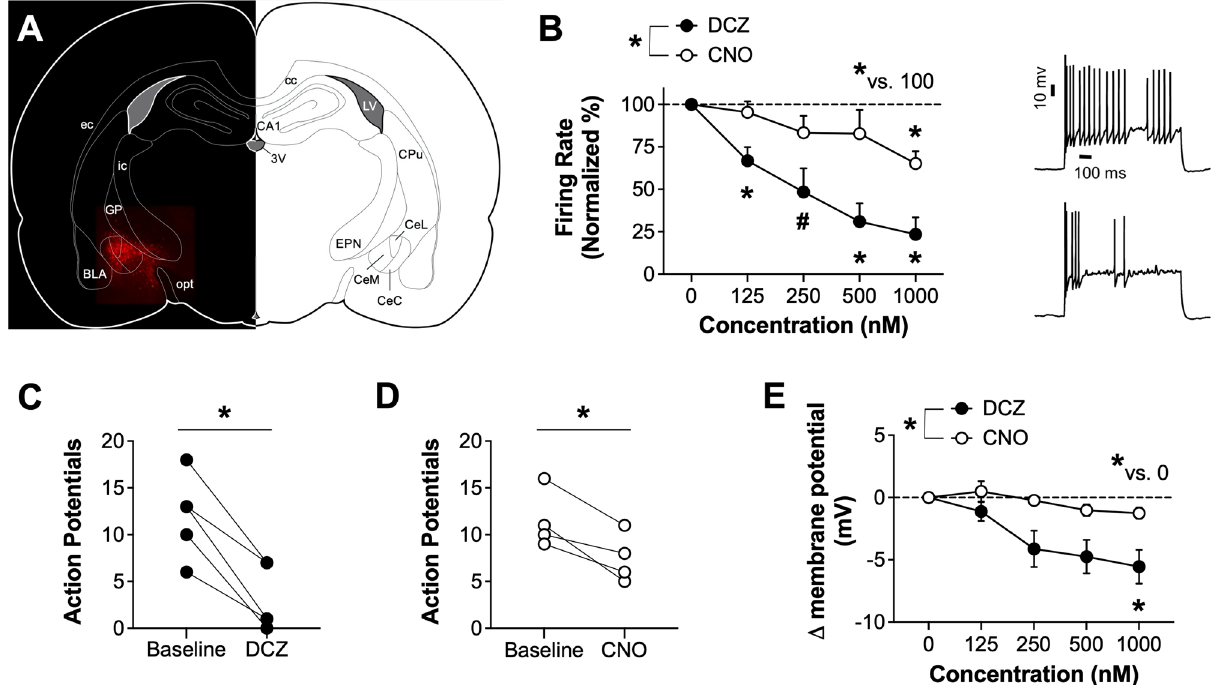
Figure 2. Slice electrophysiology profile of DCZ and CNO in CeA neurons expressing hM4Di DREADDs. ( A ) Atlas schematic depicting viral expression of hM4Di.mCherry in CeA neurons targeted for slice electrophysiology recordings. ( B ) Left: Concentration–response curve depicting percent inhibition of firing rate in CeA neurons expressing hSyn.hM4Di.mCherry during bath application of varying concentrations of either DCZ or CNO. Right: Representative traces of action potential firing in hM4Di-expressing neurons at baseline (top) or during bath application of 1000 nM DCZ (bottom). Average changes in action potential firing